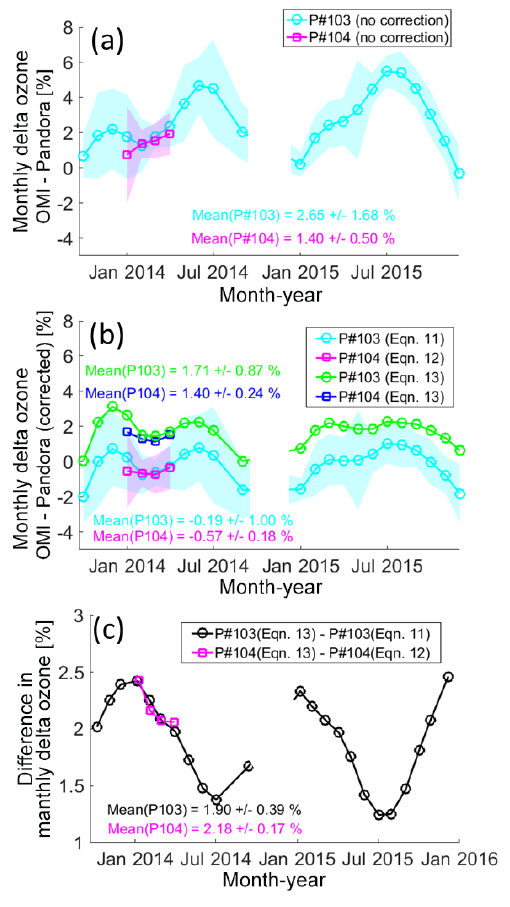
Figure 13. Monthly mean time series of the (OMI − Pandora) / OMI % TCO difference: (a) before applying the correction, (b) after applying the correction using Eqs. (11)–(13), and (c) the difference between the corrections. The shaded regions represent the 1 σ